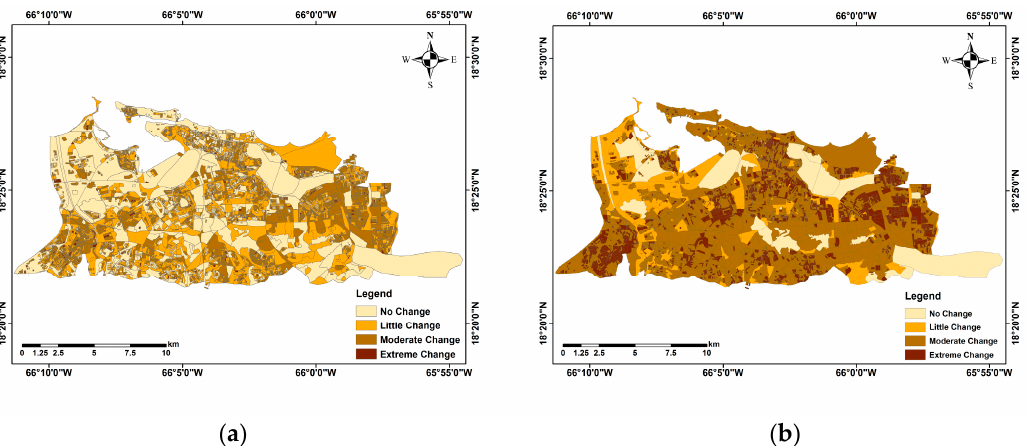
Figure 13. San Juan, Puerto Rico standard deviation map ( a ) shows lower standard deviation on street blocks before the hurricane and ( b ) shows higher standard deviation calculated after.